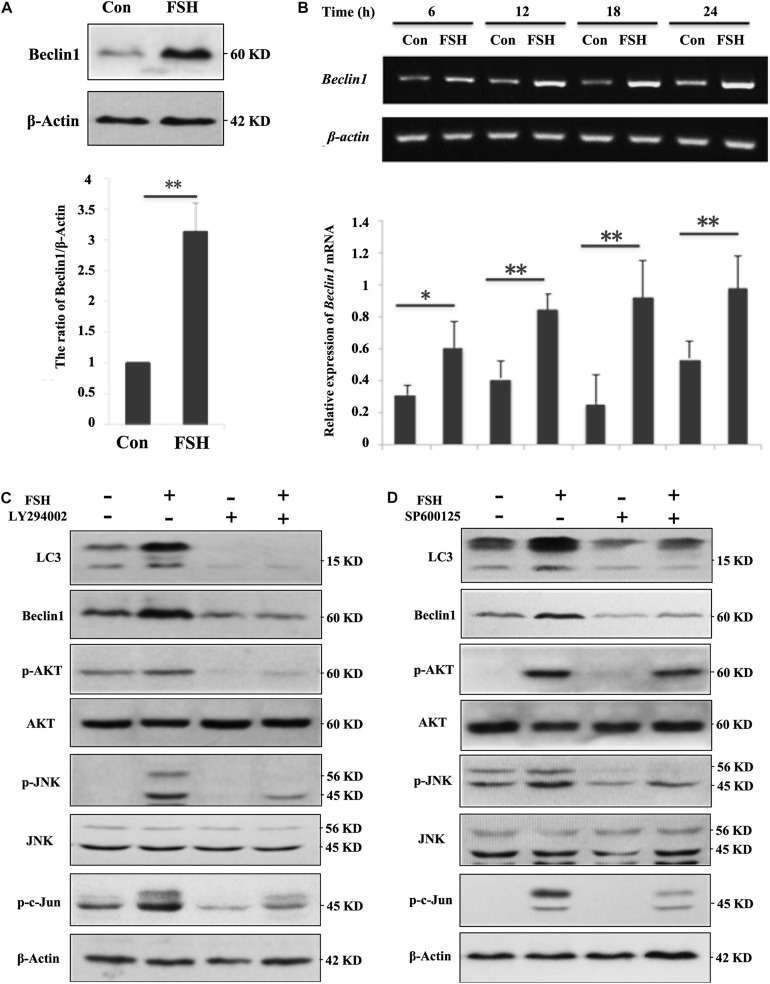
FSH upregulates beclin1 expression in porcine GC mass via the PI3K/JNK/c-Jun pathway. (A) GC mass were cultured in DMEM/F12 medium containing 0.01 IU/mL FSH for 24 h, beclin1 and β-actin levels were detected by western blotting of the whole cell lysates. (B) GC mass were cultured in DMEM/F12 medium containing 0.01 IU/mL FSH for the indicated hours, and total RNA was collected for cDNA synthesis. Expression of beclin1 and β-actin mRNA was measured by PCR assay. (C) GC mass were pre-treated with LY294002 (10 μM, inhibitor of PI3K/AKT signaling pathway) for 1 h before stimulation with 0.01 IU/mL FSH for 24 h, p-AKT, AKT, p-JNK, JNK, p-c-Jun, Beclin1, and β-actin levels were detected in whole cell lysates. (D) GC mass were pre-treated with SP600125 (10 μM, inhibitor of SAPK/JNK signaling pathway) for 1 h before stimulation with 0.01 IU/mL FSH for 24 h, p-AKT, AKT, p-JNK, JNK, p-c-Jun, Beclin1, and β-actin levels were detected in the whole cell lysates. ∗∗, P < 0.01, and ∗, P < 0.05 compared to the control group.